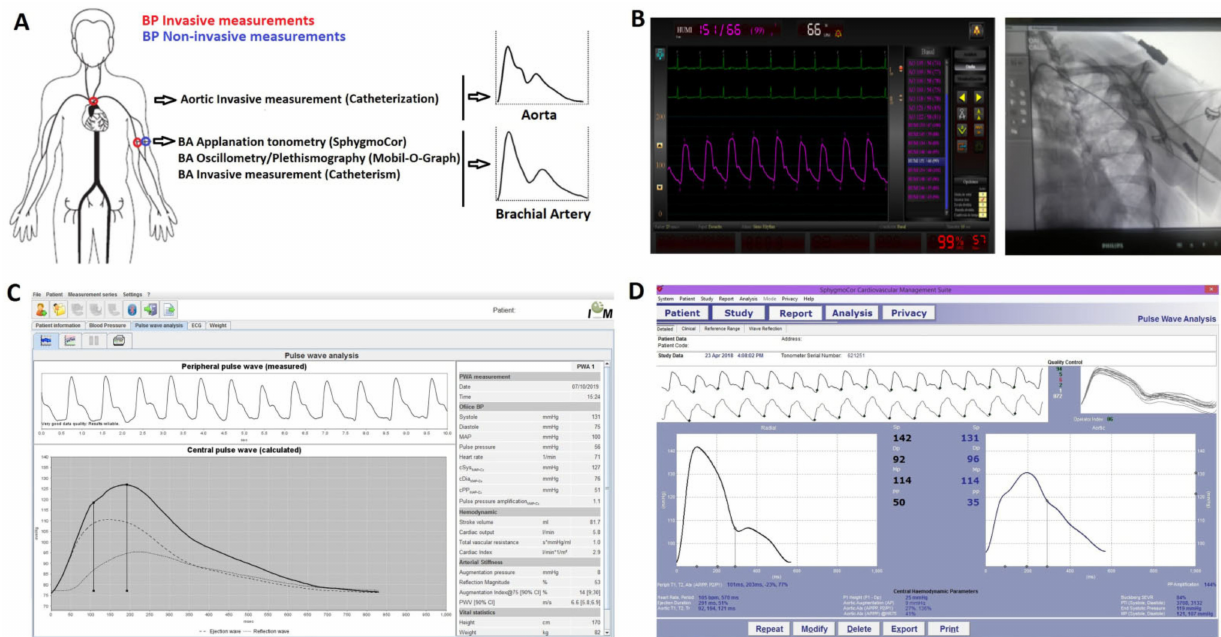
Figure 1. Schematic representation of invasive and non-invasive aortic and brachial blood pressures (BP) measurements ( A ). Invasive brachial recordings ( B ). Non-invasive approaches using oscillometry ( C ) and applanation tonometry ( D